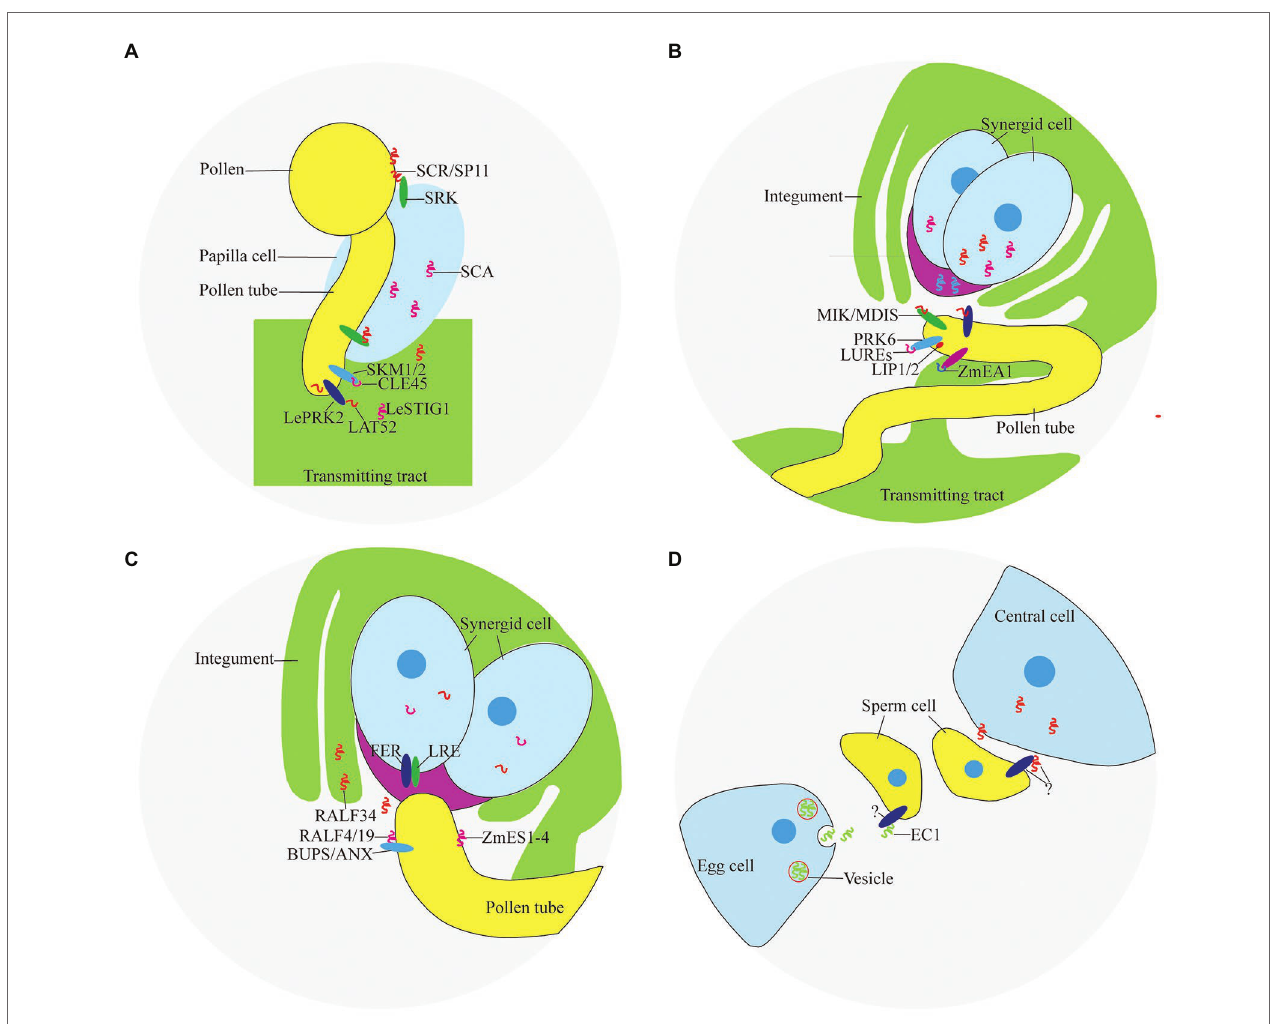
FIGURE 2 | Peptides and receptors involved in double fertilization. (A) Pollen-stigma interaction; (B) ovule attraction; (C) pollen tube reception; and (D) gamete